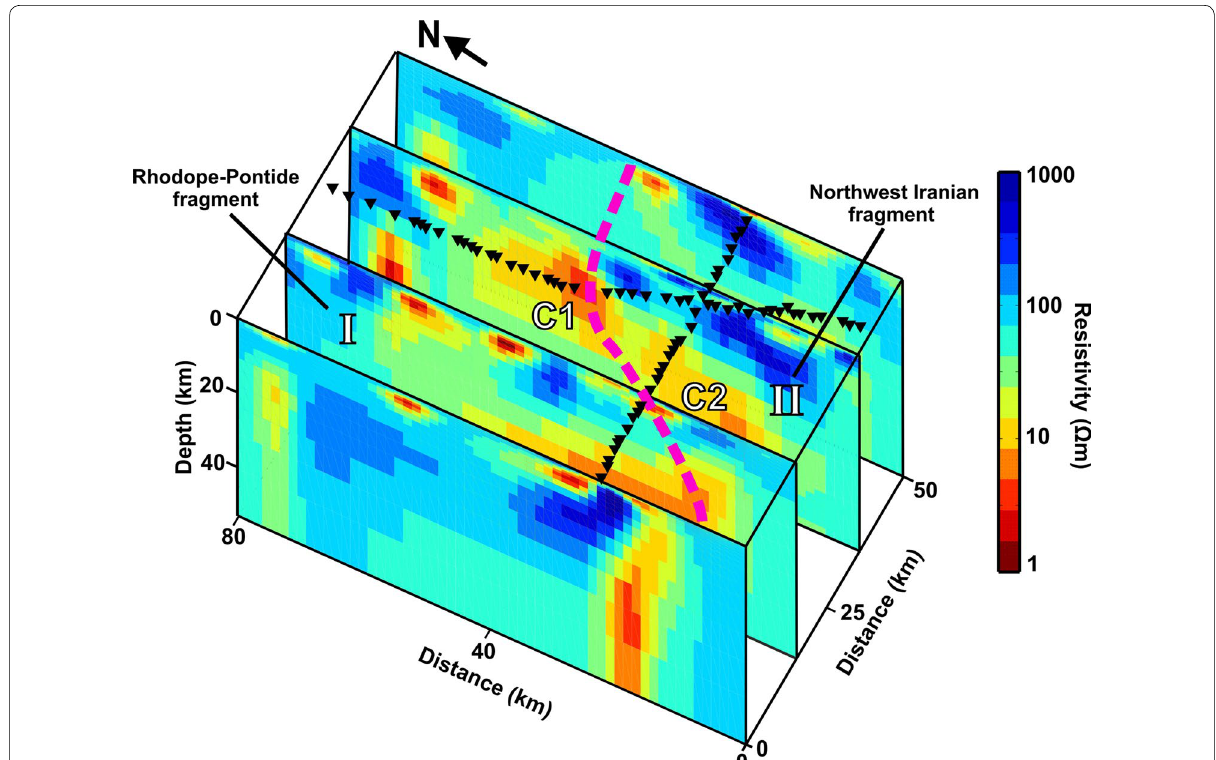
Fig. 4 3D perspective view displaying vertical north–south slices through the model and site locations at surface. The pink broken line displays the approximate boundary of the tectonic blocks (modified from Şengör et al. 2003), the Rhodope-Pontide and Northwest Iranian fragments. The conductive features C1 and C2 explained in the text